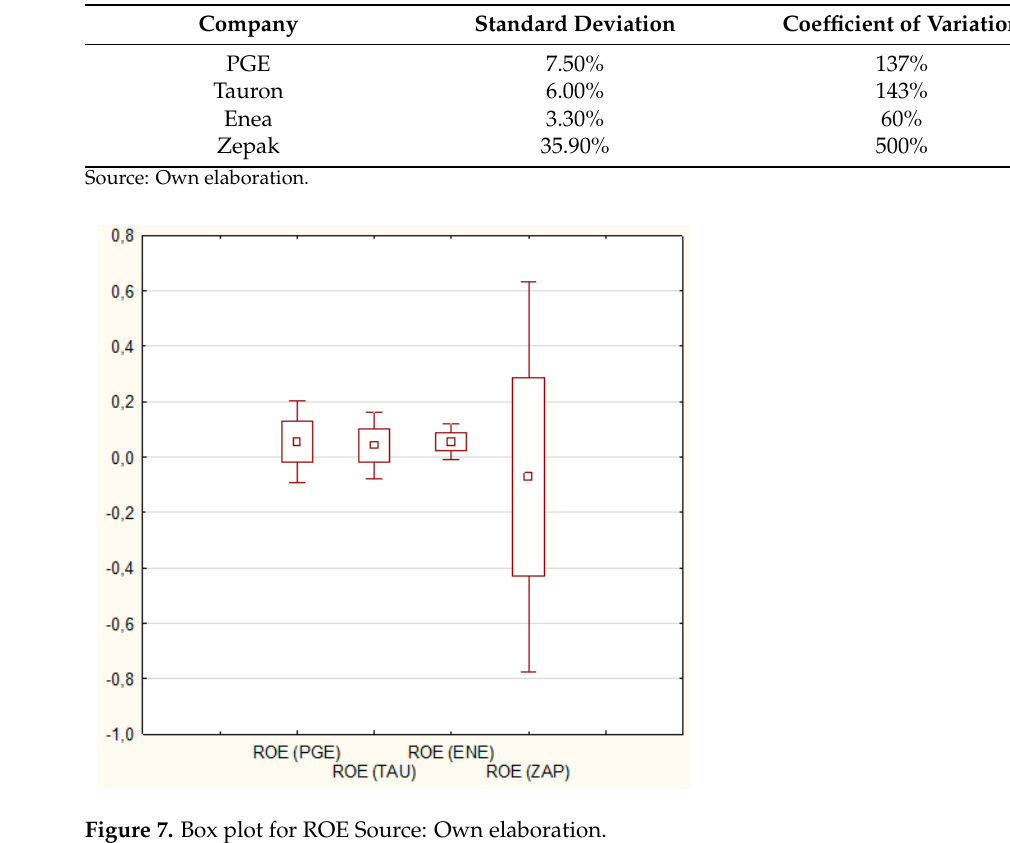
Figure 8. ROS ratios for the analyzed companies in 2009–2019 (%). Source: Own elaboration.